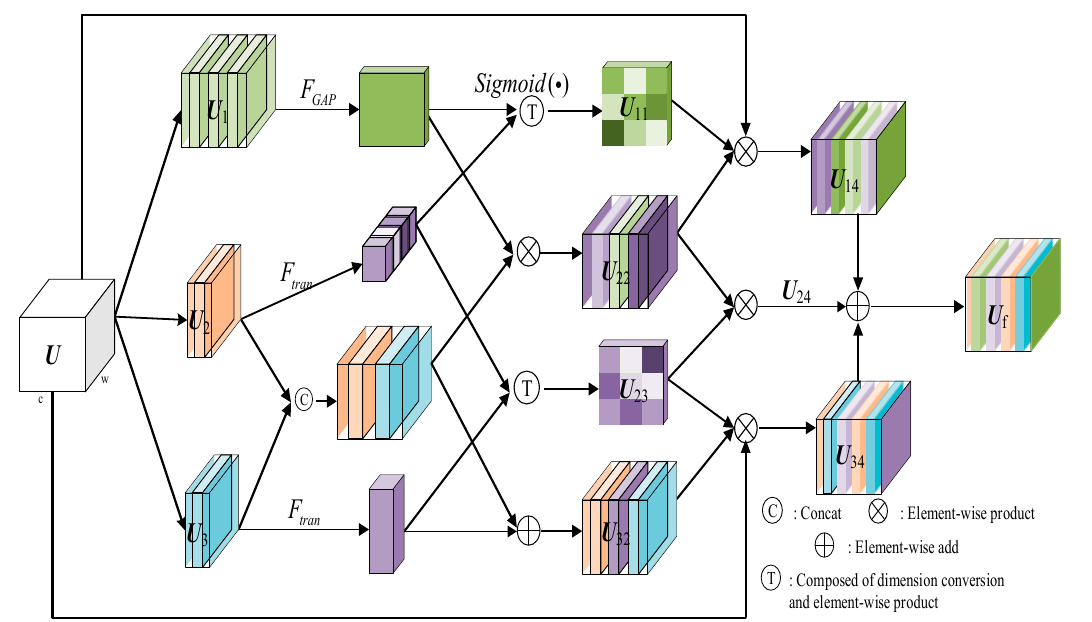
Figure 2. Feature information–interaction model.